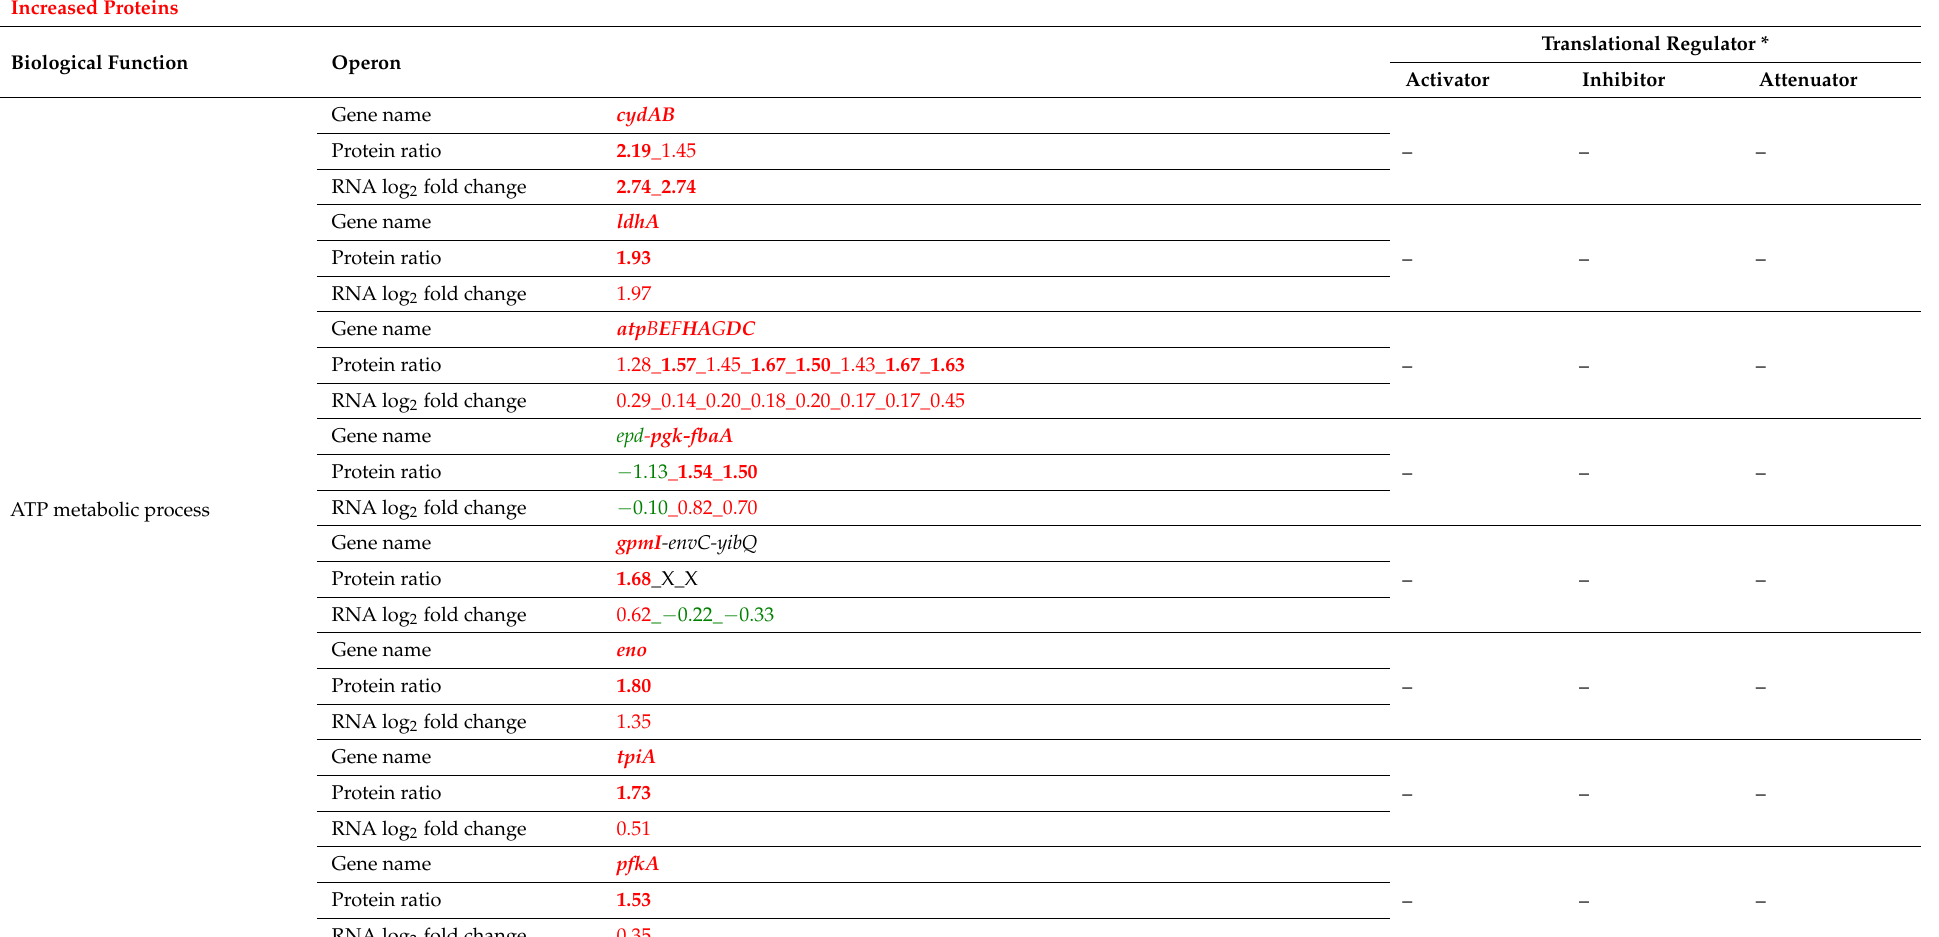
Table 6. Functional classification of increased and decreased